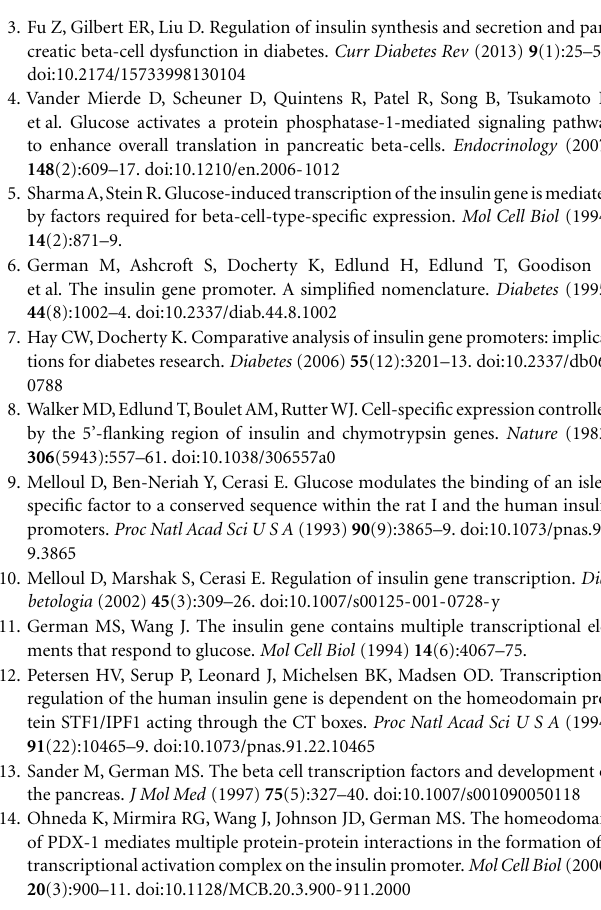
FIGURE 5 | Functional significance of HMGA1 for glucose-induced INS gene expression and insulin secretion . (A) ChIP of the rat Ins promoter gene in INS-1 cells treated with either basal (3mM) or stimulatory (15mM) glucose concentrations, using an anti-HMGA1 specific antibody (Ab). A representative assay is shown, together with qRT-PCR of ChIP-ed samples.